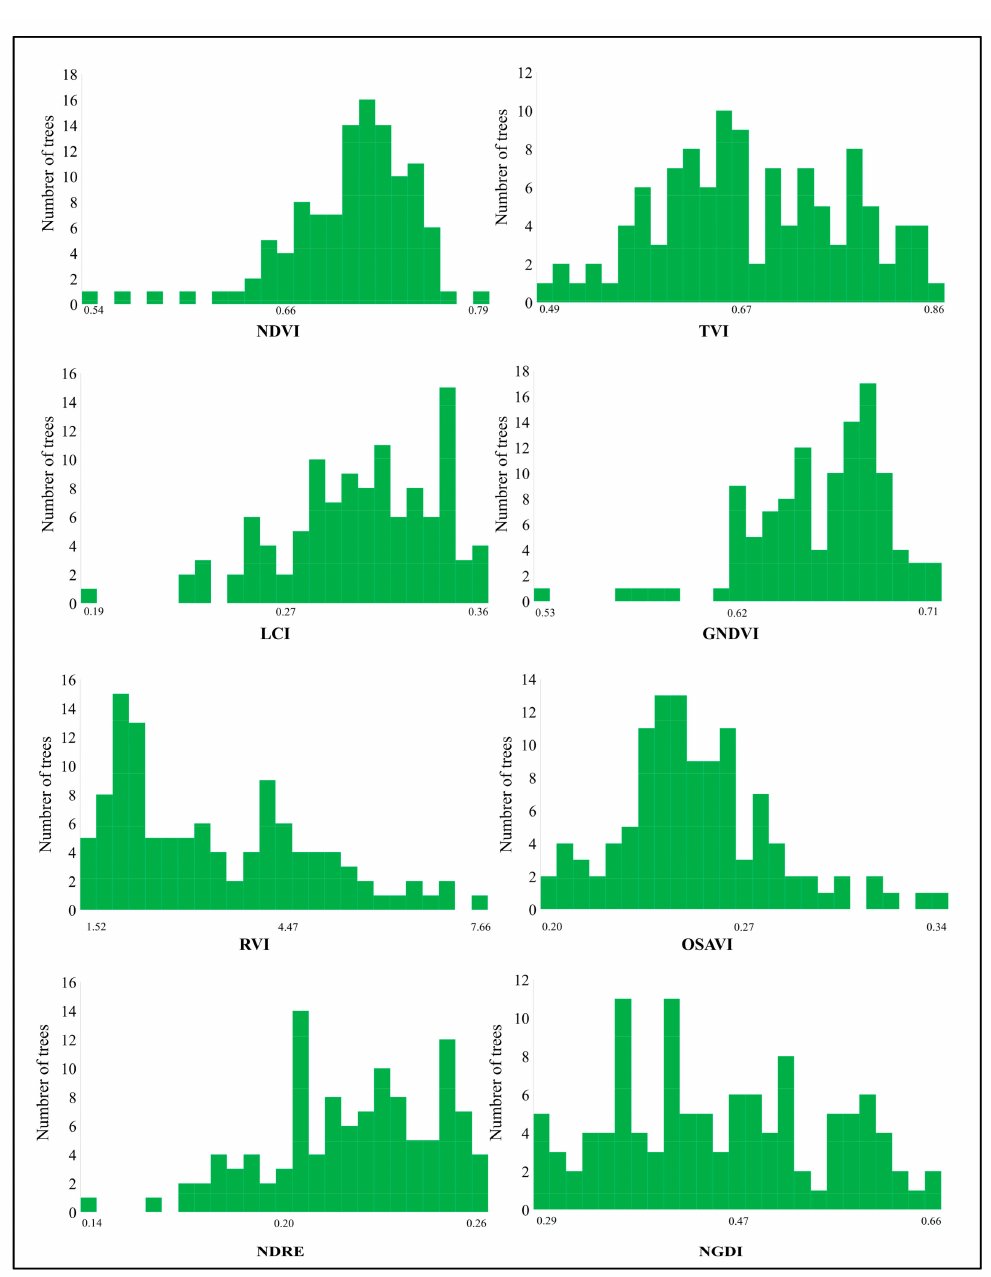
Figure 10. Individual-tree vegetation-index distribution in Pinus arizonica Engelm. clonal